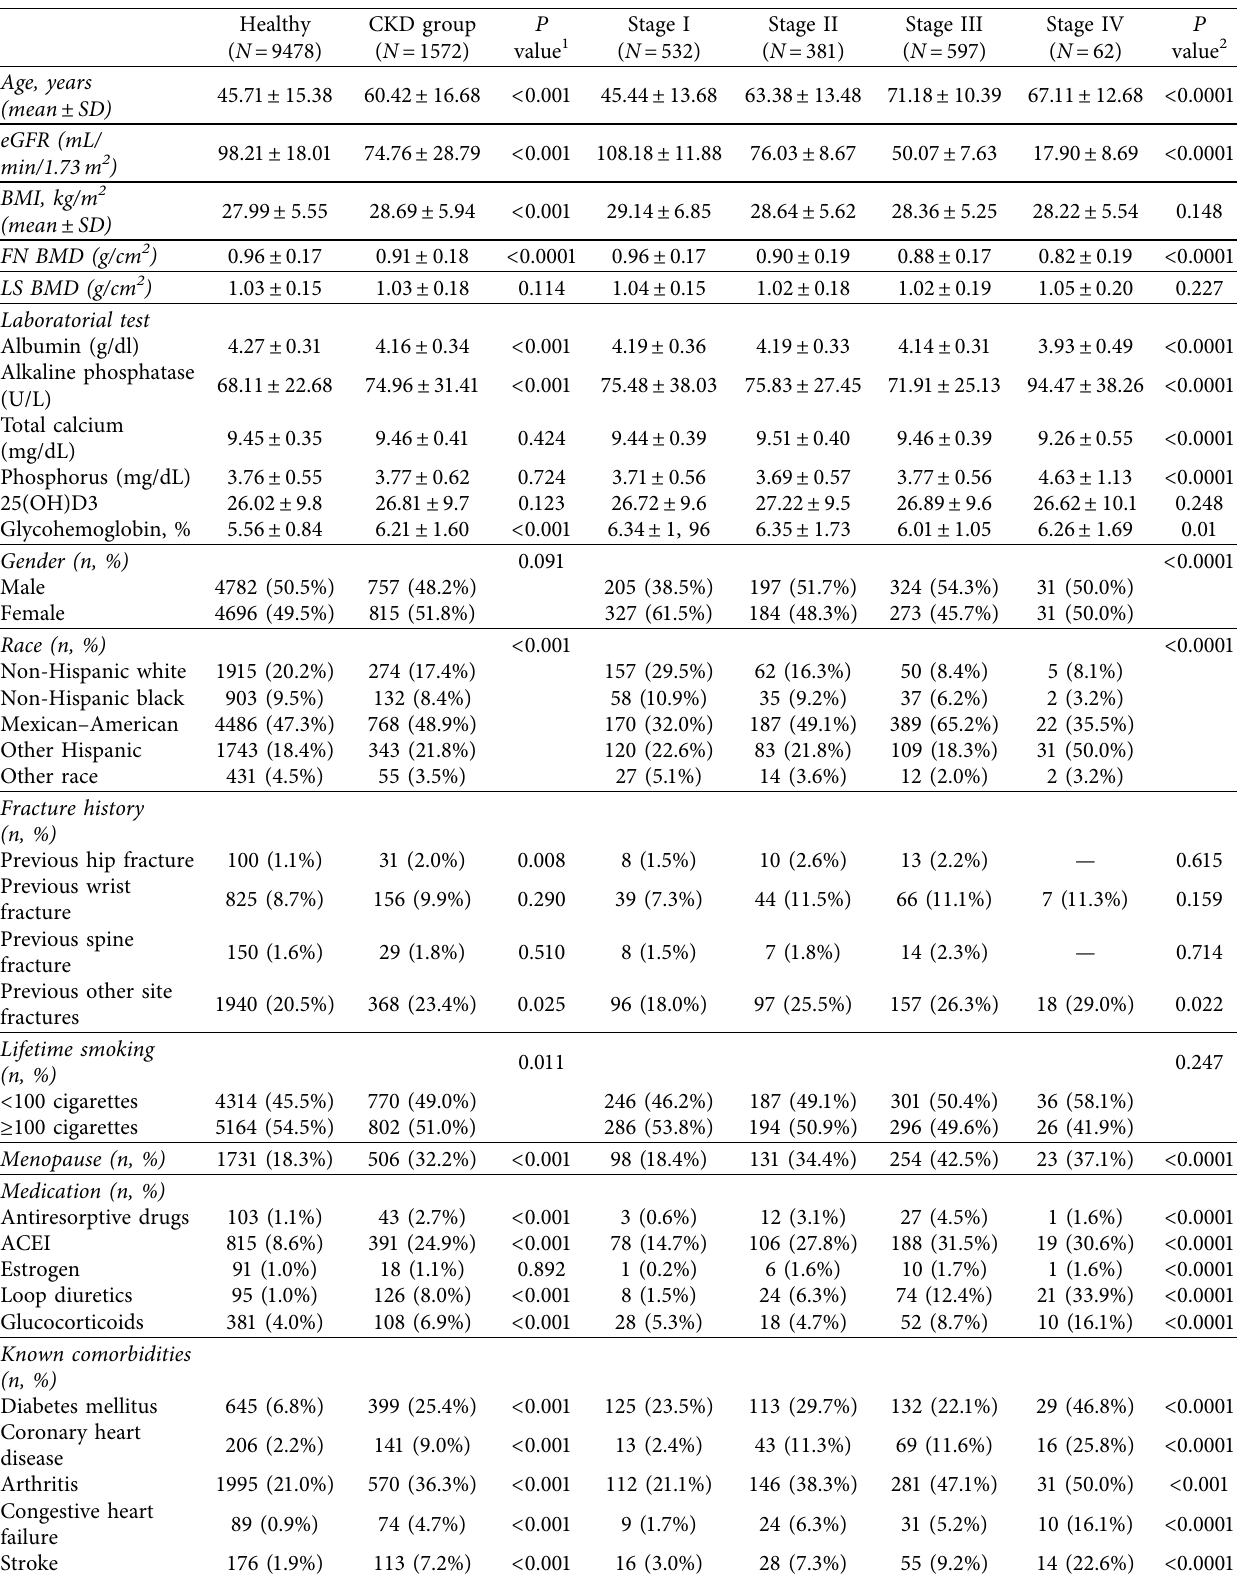
Table 1: Comparison of sample characteristics between those with chronic kidney disease according to current chronic kidney disease